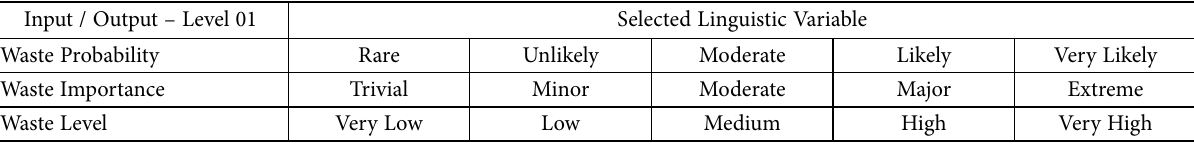
Table 1. Linguistic variables for inputs and outputs used in Level 01 of LCEM